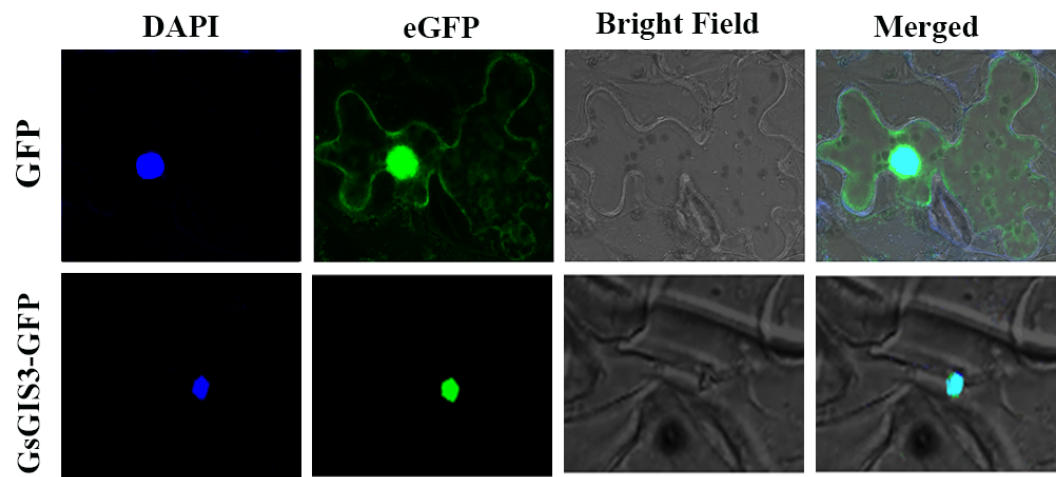
Figure 2. Subcellular localization of GsGIS3 protein. Subcellular localization of GsGIS3 protein in leaf epidermal cells of tobacco. The protein expression of GFP or GsGIS3-GFP from the leaves after agro-infiltration for 48 h was visualized using a confocal laser scanning microscope (Leica, Germany) [39].